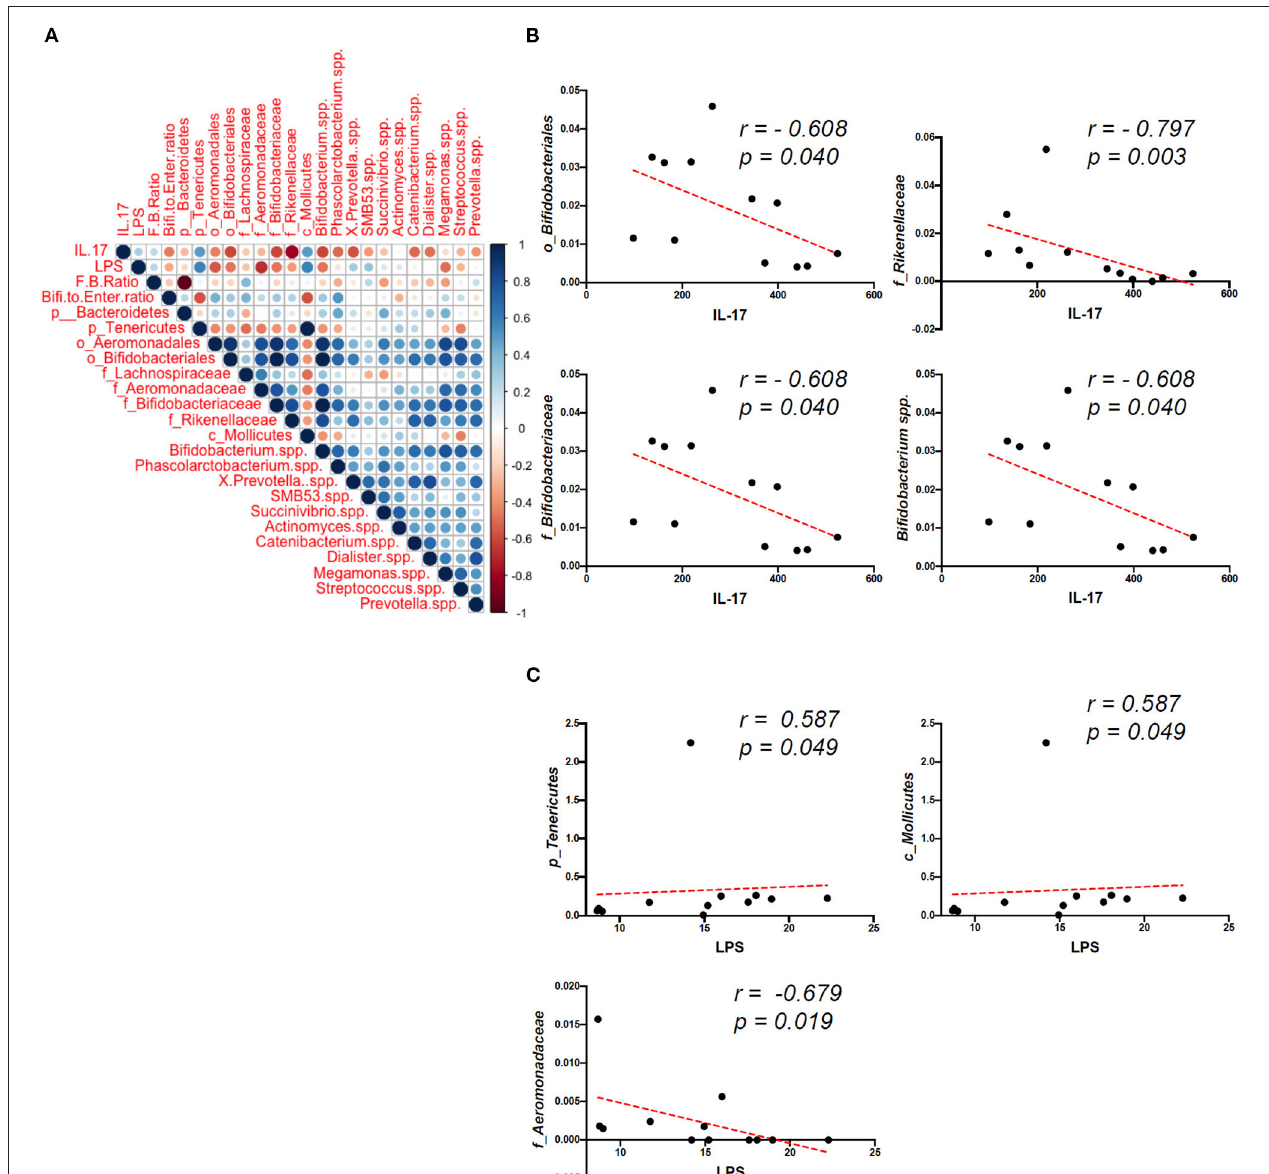
FIGURE 7 | Correlations between the gut microbiota composition and plasma concentrations of IL-17 and LPS in the sham and OVX mice treated with either the vehicle (H 2 O) or heat-killed GMNL-653. (A) Spearman’s correlation coefficient strength of the phylum counts from the OVX mice. Correlations with P < 0.05 are indicated, and the strength of the coefficient is represented by the change in color intensity. (B) The enriched Bifidobacteriales (order), Rikenellaceae (family), Bifidobacteriaceae (family), and Bifidobacterium spp. in the OVX + GMNL653 group exhibited a significant negative correlation with sera IL-17. (C) The enriched Tenericutes (phylum) and Mollicutes (class) in the OVX group were positively correlated with sera LPS. The enriched Aeromonadacae (family) in the OVX + GMNL-653 group exhibited a negative correlation with sera